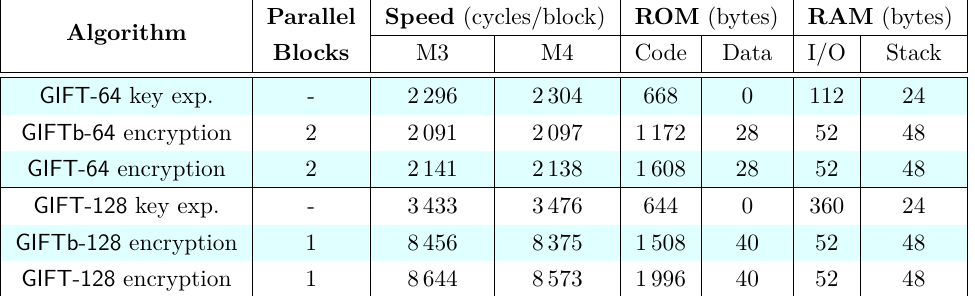
Table 3: Naive bitsliced implementation results on ARM Cortex-M3 and M4 for various versions of GIFT . Algorithm